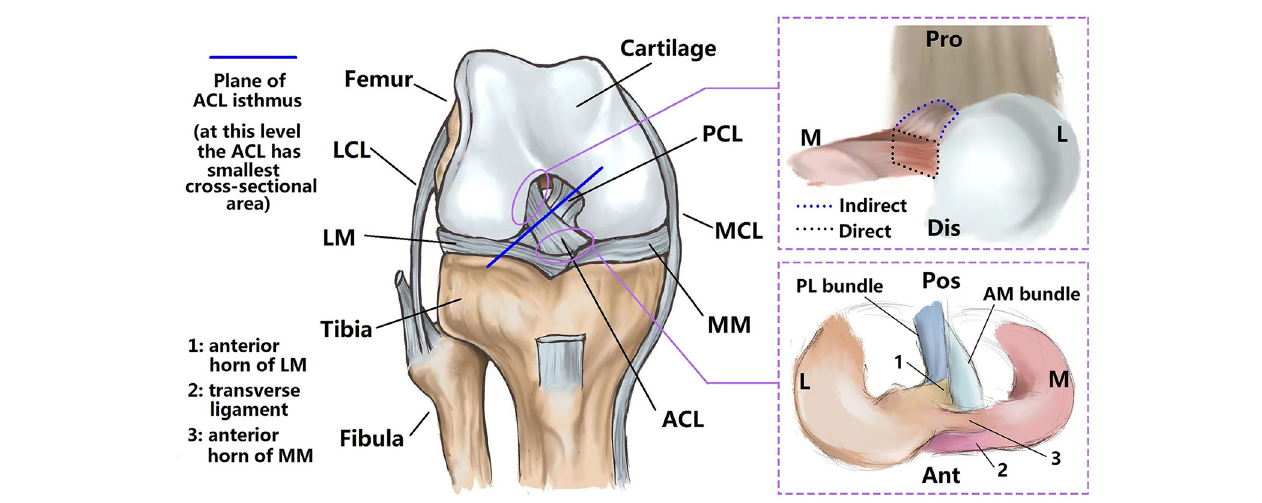
FIGURE1 Sketch of intact knee joint. The ACL has a characteristic hourglass shape (fans out to its bony insertion sites) (left) . Bone insertions can be divided into direct and indirect types. The direct insertion connects to the midsubstance fibers, while the indirect insertion extends from the direct insertion to the bone, but is not directly connected with the midsubstance fibers (upper right) . The anterior horn of the lateral meniscus inserts into the ACL substance and passes through the interface between tibial insertion sites of the anteromedial and posterolateral bundles of the ACL (lower right) . LCL, lateral collateral ligament; LM, lateral meniscus; MM, medial meniscus; MCL, medial collateral ligament; PCL, posterior cruciate ligament; Pro, proximal; M, medial; L, lateral; Dis, distal; Pos, posterior; Ant,